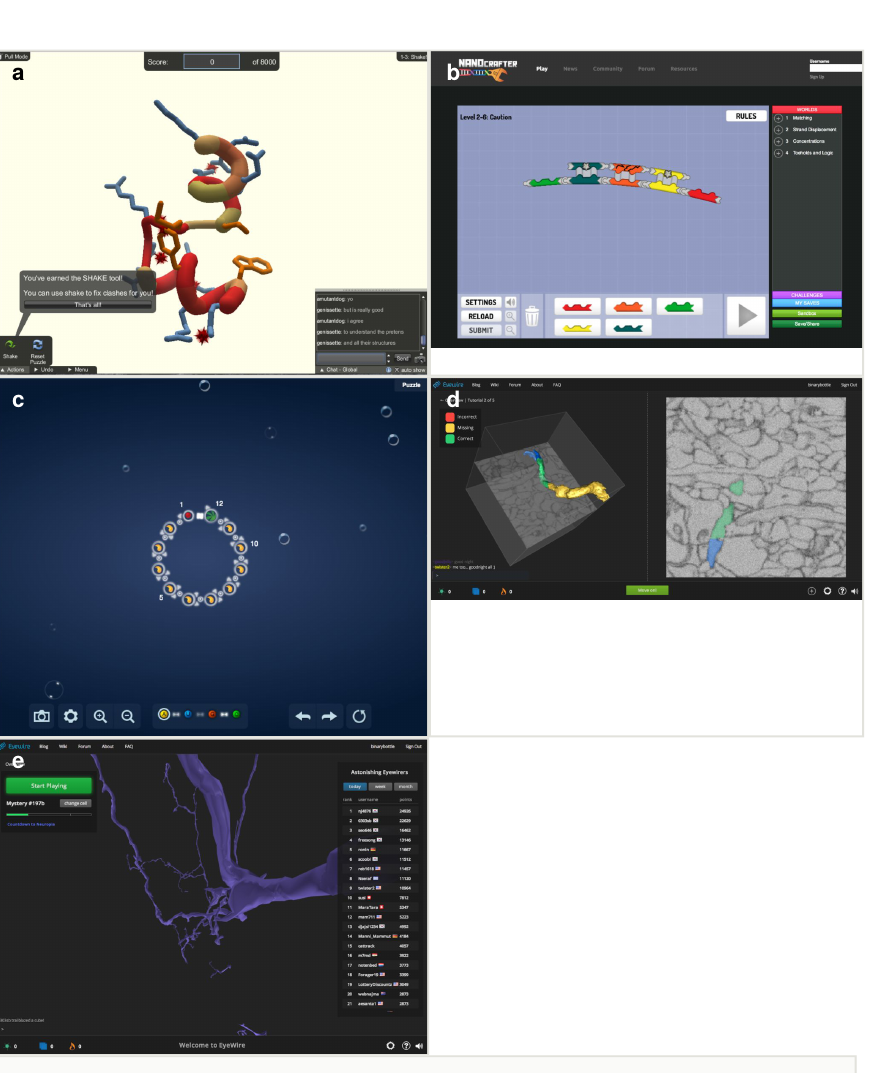
Figure 3. Screenshots of popular scienti fi c